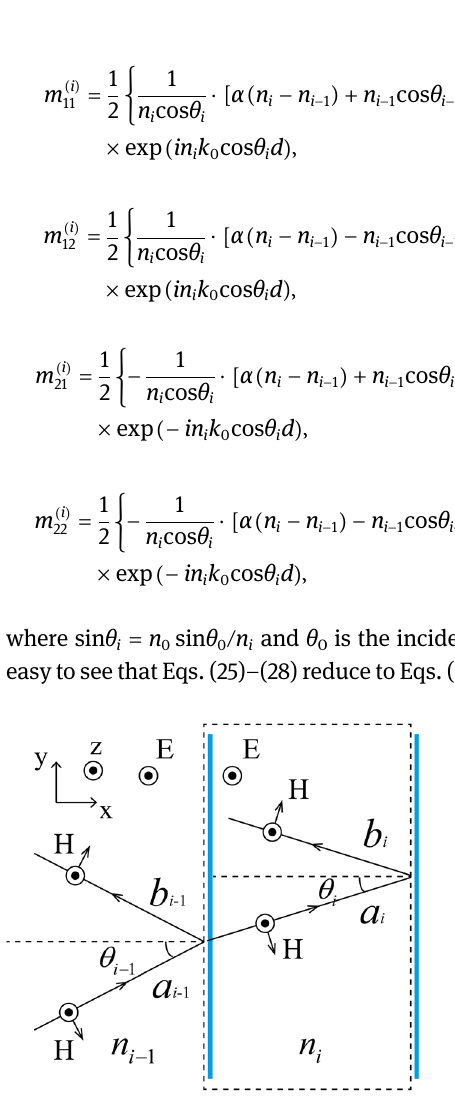
Figure 2: (Color online) (a) The ensemble averaged ln T N as a function of the sample length L for different values of α < 1. (b) Same as (a), but for α > 1. The purple, yellow, blue and green solid circles in (a) denote the numerical results for α = 0.999, 0.998, 0.997 and 0.996, respectively, while in (b) for α = 1.002, 1.004, 1.006 and 1.008. The solid lines are linear fi ts for different values of α in both (a)and(b).The insetsshowthe localization length ξ retrieved from the slope of the linear fi t for different values of | α − 1 | (solid